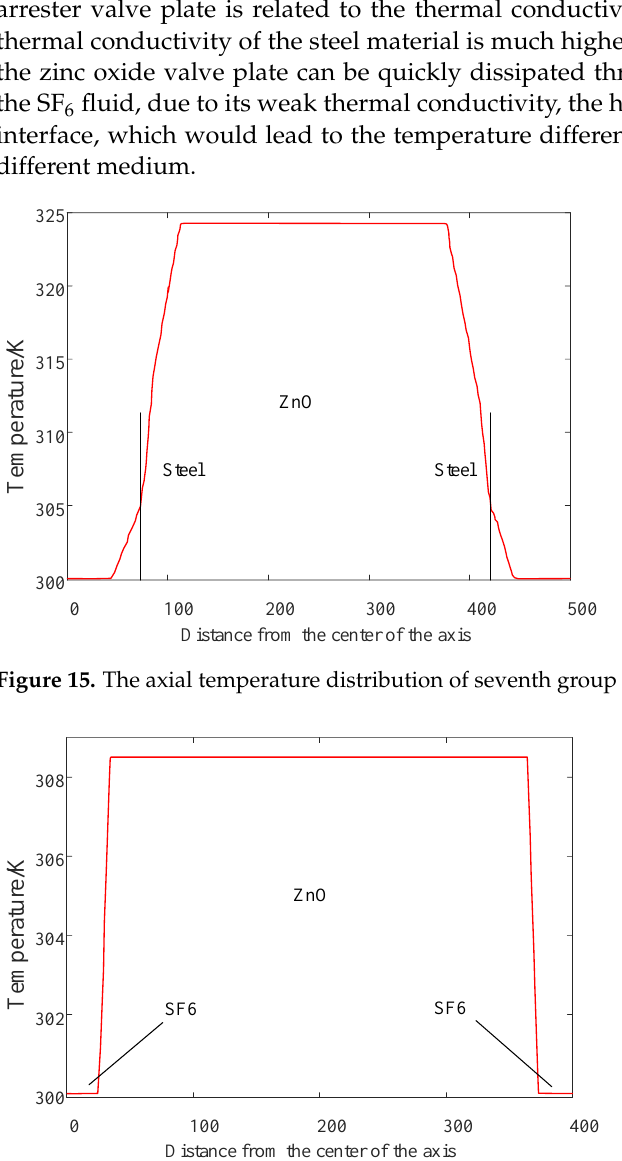
Figure 14. The temperature distribution of the seventh group valve plate.